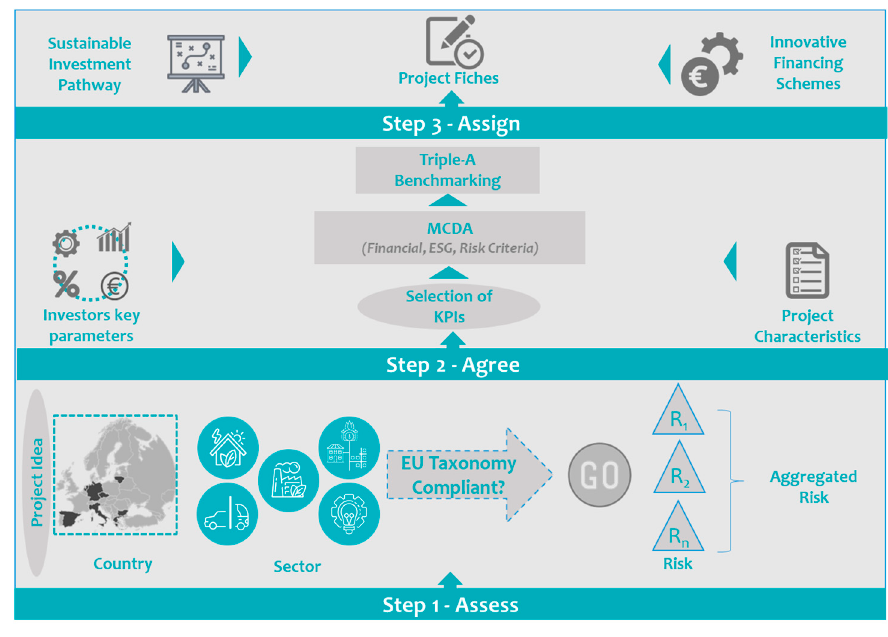
Figure 2. Triple-A